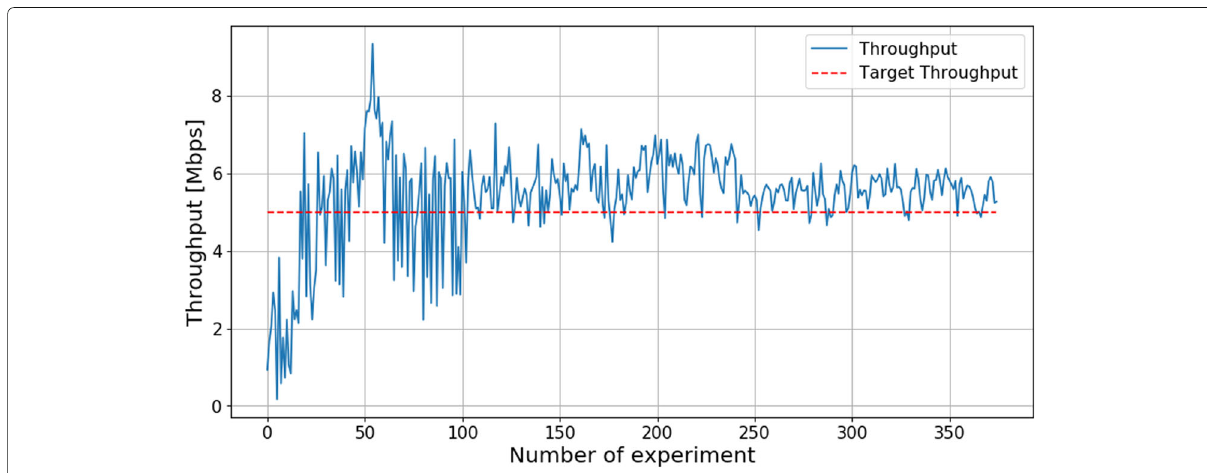
figuration parameters, with which the target values of the measured user performance indicators are achieved, are